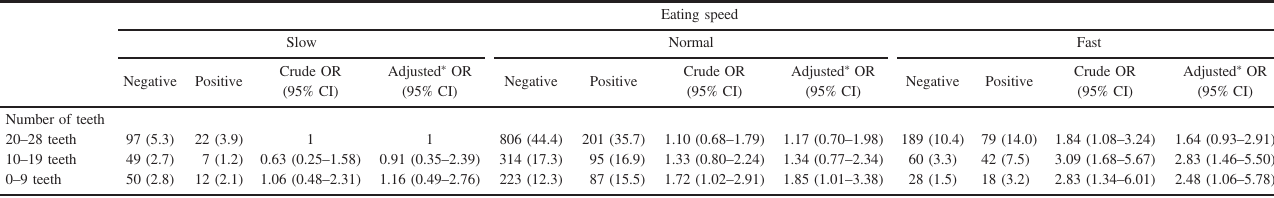
CI, con fi dence interval; OR, odds ratio. + Adjusted for age, sex, smoking habit, exercise habit, weight gain since 20 years of age, intake drug to reduce cholesterol, using secondary oral hygiene products, and Community periodontal index.